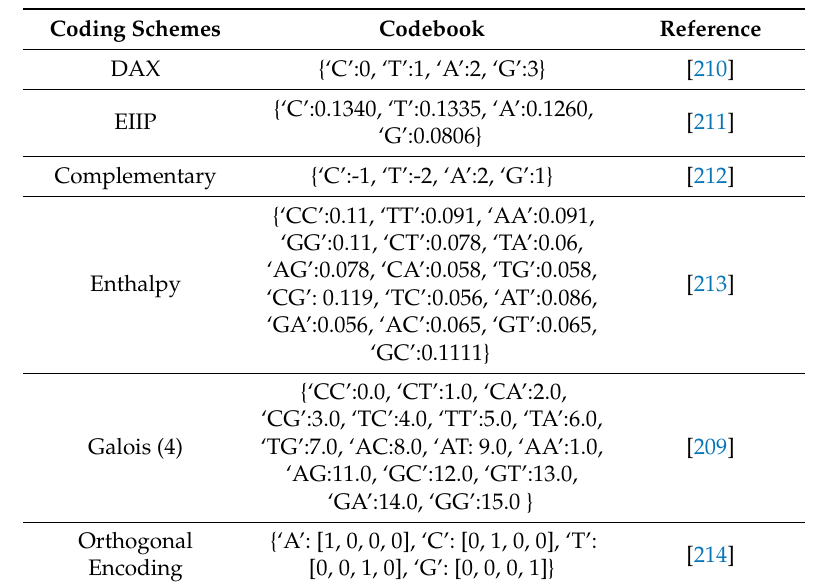
Table 6. Coding schemes for the translation of DNA characters into numerical representations. Adapted from